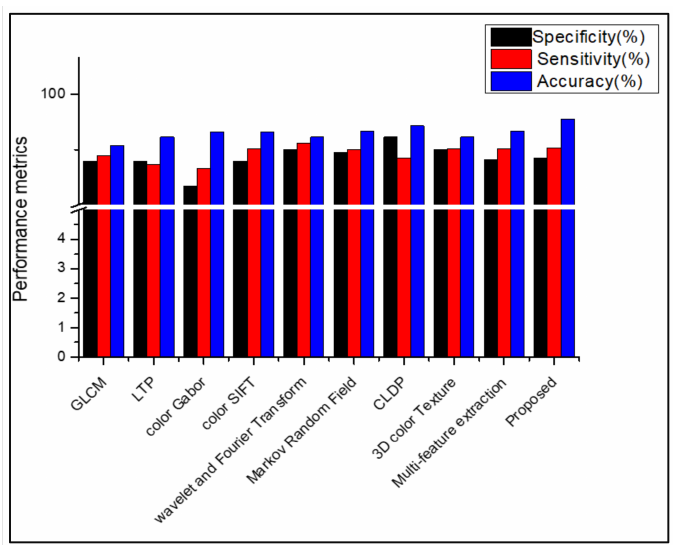
Figure 11. Comparison of performance using various features in ISIC 2017.